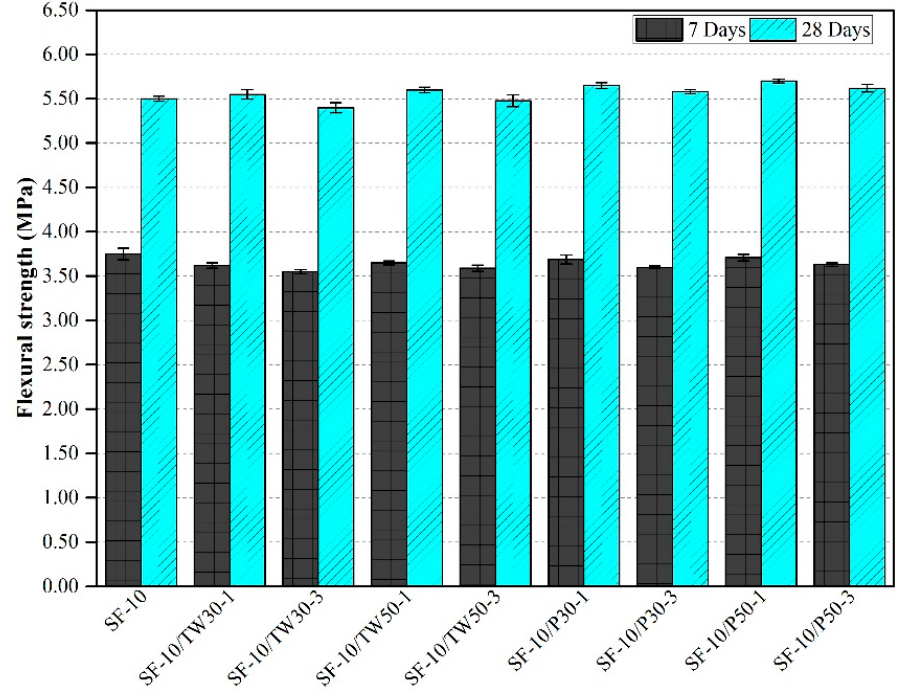
Figure 6. Flexural strength of mortars made with tea waste and perlite particles with 10% SF.